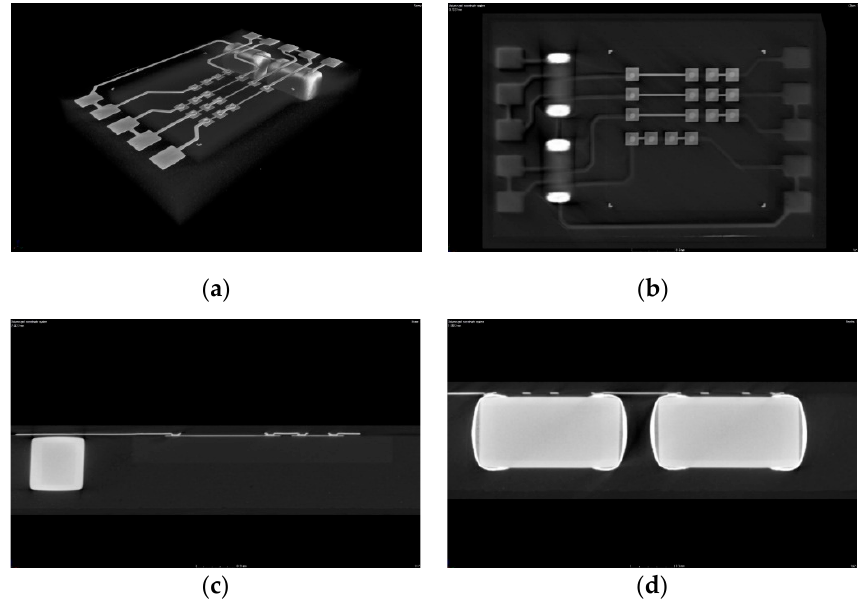
Figure 10. X-ray CT package analysis; ( a ) package overview, ( b ) package top layer; ( c ) virtual cross section through chip interconnects, ( d ) virtual cross section through SMD interconnects.